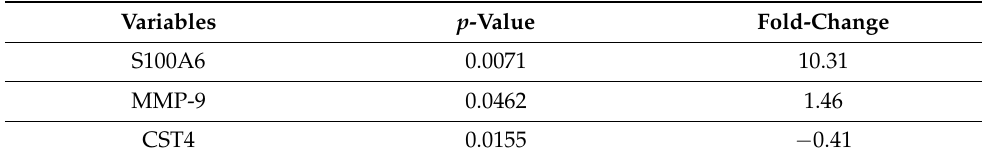
Table 2. Dysregulated biomarkers comparing the SS versus CT